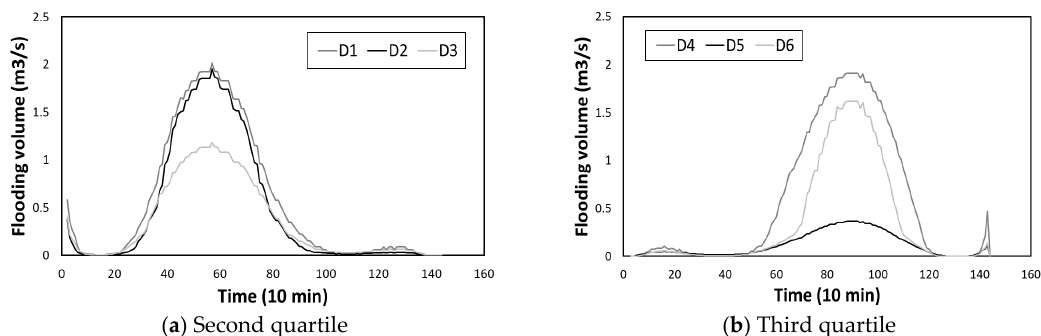
Figure 6. Flooding hydrograph in scenario-optimal solutions under corresponding individual scenarios. ( a ) Second quartile and ( b ) third quartile.